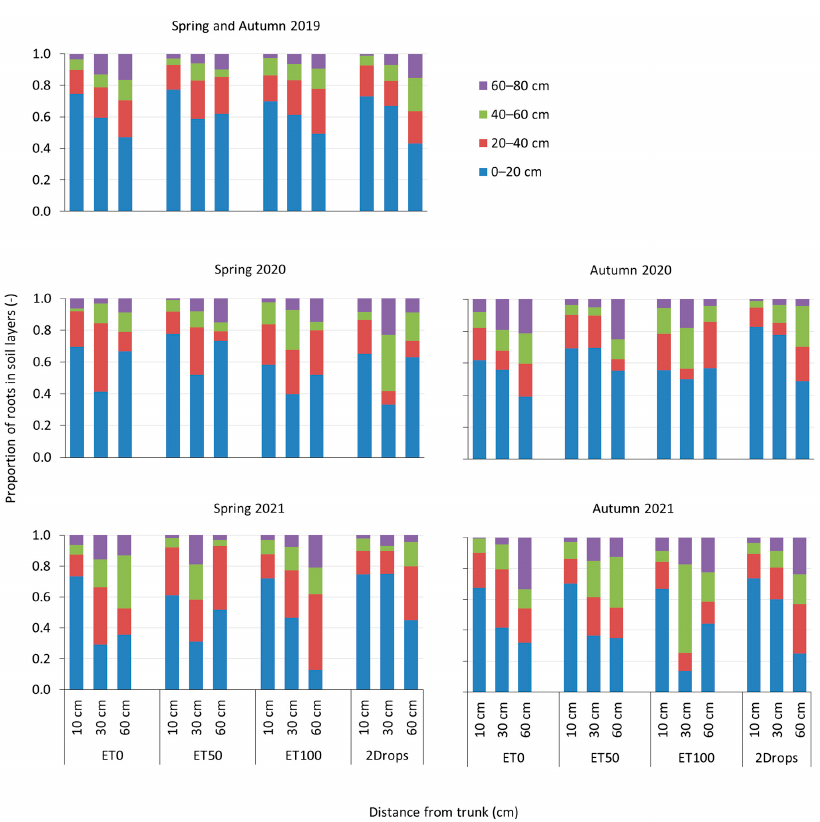
Figure 6. Proportion of the root density (RDt) in the soil layers (0–20 cm, 20–40 cm, 40–60 cm, and 60–80 cm) in increasing distance from the trunk (10 cm, 30 cm, and 60 cm), in the spring and autumn sampling terms. ET0, ET50, ET100, and 2Drops refer to irrigation water rate variants (see Figure 5). The decrease in the roots with depth was less apparent in the root density of new vital roots (Figure 7). The RDv represented, on average, 37% (autumn 2019), 15%, and 24% (spring and autumn 2020), and 22% and 24% (spring and autumn 2021) of the RDt. The proportions of RDv on RDt increased from the top 0–20 cm layer to the 60–80 cm layer. In 2019, the new vital roots represented, on average, 17%, 31%, 37%, and 66% of the RDt; in 2020, the averages were 9%, 17%, 27%, and 25%; in 2021, the corresponding values were 15%, 23%, 27%, and 26% in the respective soil layers. The RDv also decreased with dis- tance from the trunk, but the decrease was less steep than in the RDt (Figure 7).